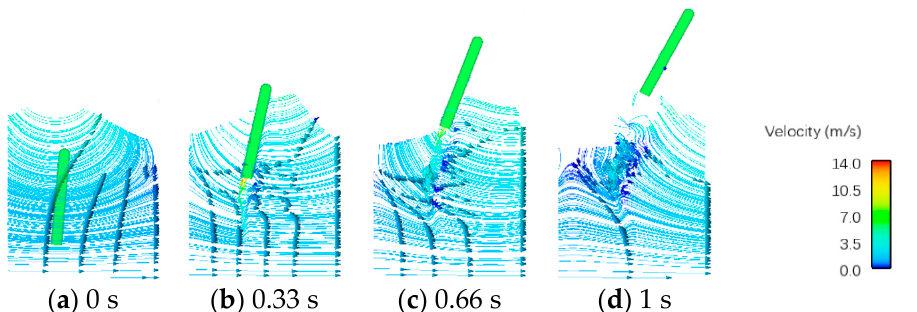
Figure 12. Streamline diagram of vehicle flying out of water in case 2.